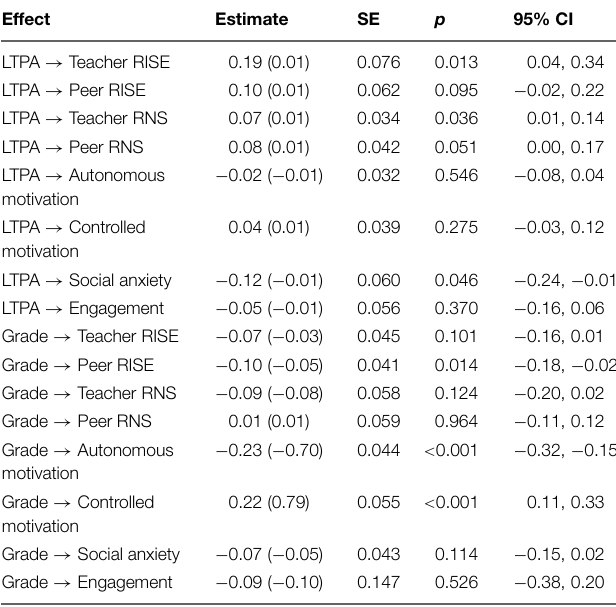
TABLE 3 | Standardized output for all covariate pathways specified within the model (unstandardized estimate in parentheses).